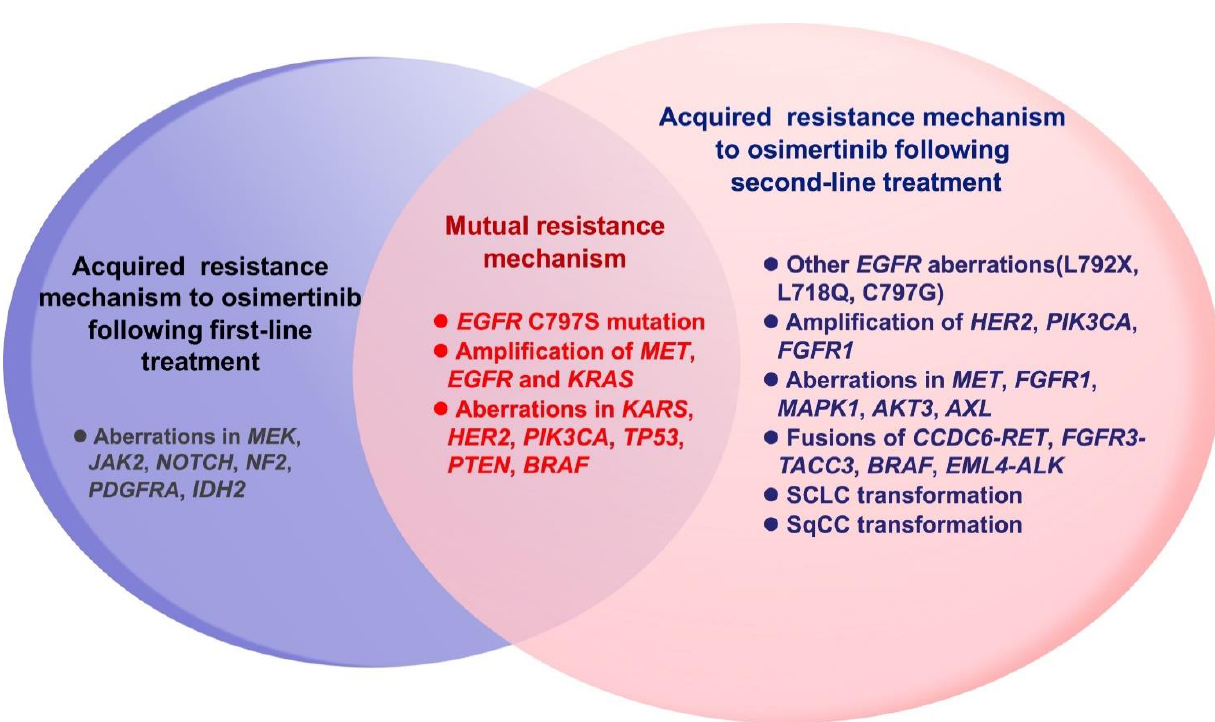
Figure 5. Differences in drug resistance mechanisms between first-line and second-line after the third-generation EGFR-TKIs treatment.